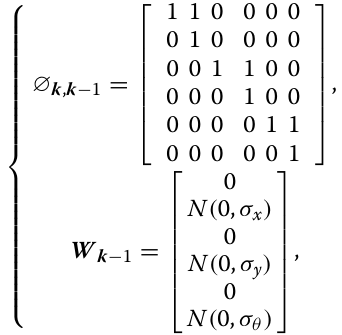
∅ where X k is the state vector, and k , k − 1 is the state transi- tion matrix. Z k is the observation vector. H k is the obser- vation matrix. W k − 1 and V k denote the system noise and the observation noise, respectively. W k − 1 obeys N 0, Q k − 1 distribution and V k obeys N ( 0, R k ) . (cid:31) (cid:30) ˙ θ ] T , x , y With the state vector X k = [ x , ˙ x , y , ˙ y , θ , denote the lateral and vertical displacements of the current frame concerning the reference frame, respec- tively. θ denotes the roll angle of the current frame with ∅ respect to the reference frame. k , k − 1 and W k − 1 are given by